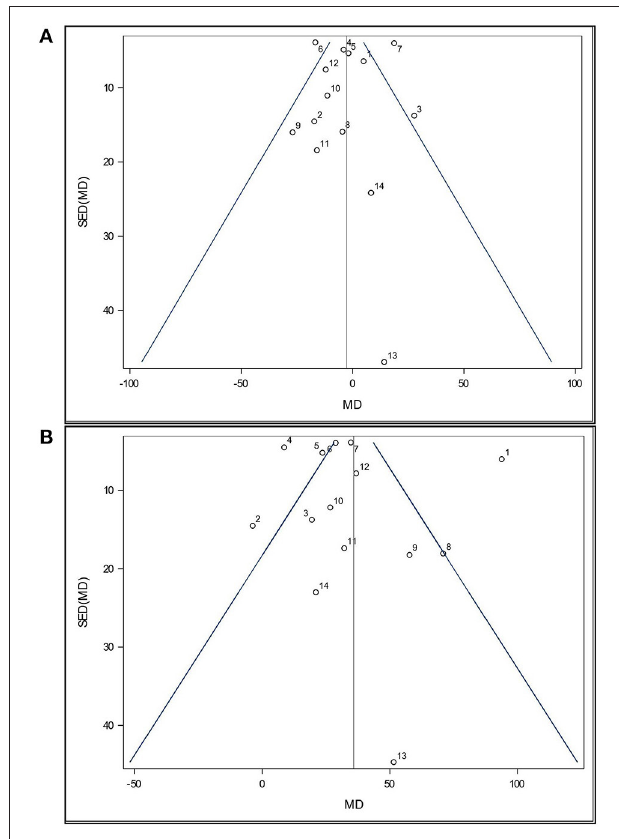
FIGURE 2 | Funnel plot of the effects of (A) Lactobacillus -based probiotic supplementation and (B) stress on time spent immobile (s) in the Forced Swim Test in rodents for all included studies ( n = 14). Dots represent mean difference (MD, Lactobacillus -based probiotic—Control; stress—non stress) and standard error of the mean difference [SE(MD)] for each study, blue lines represent 95% CI, and the black line represents the overall fixed effect